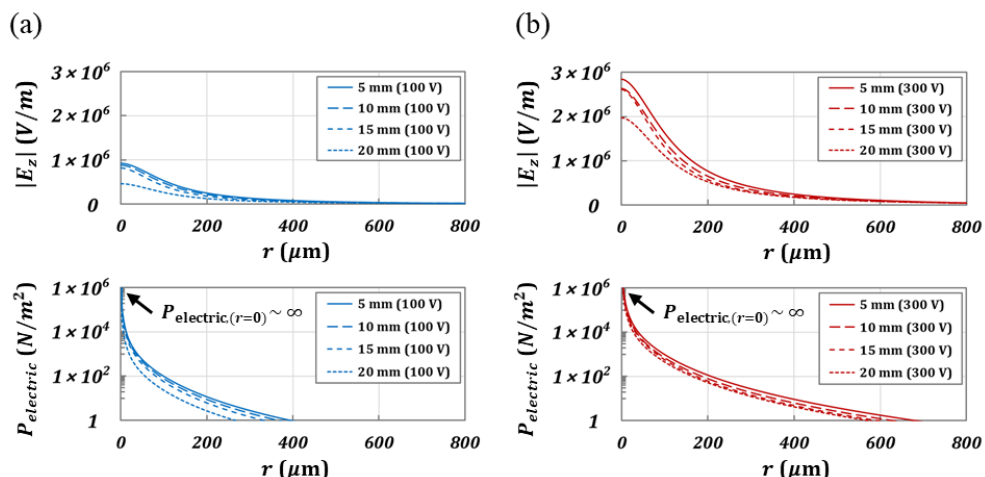
Figure 7. Effects of electric field strength and electric pressure on the suppression of dimple formation. Electric field strength ( | E z | ) and the strength of electric pressure ( P electric ) with respect to the radial location from the center of coalescence for the electrified ethanol droplet. ( a ) 100 V, ( b ) 300 V (The graph is represented on a logarithmic scale.)